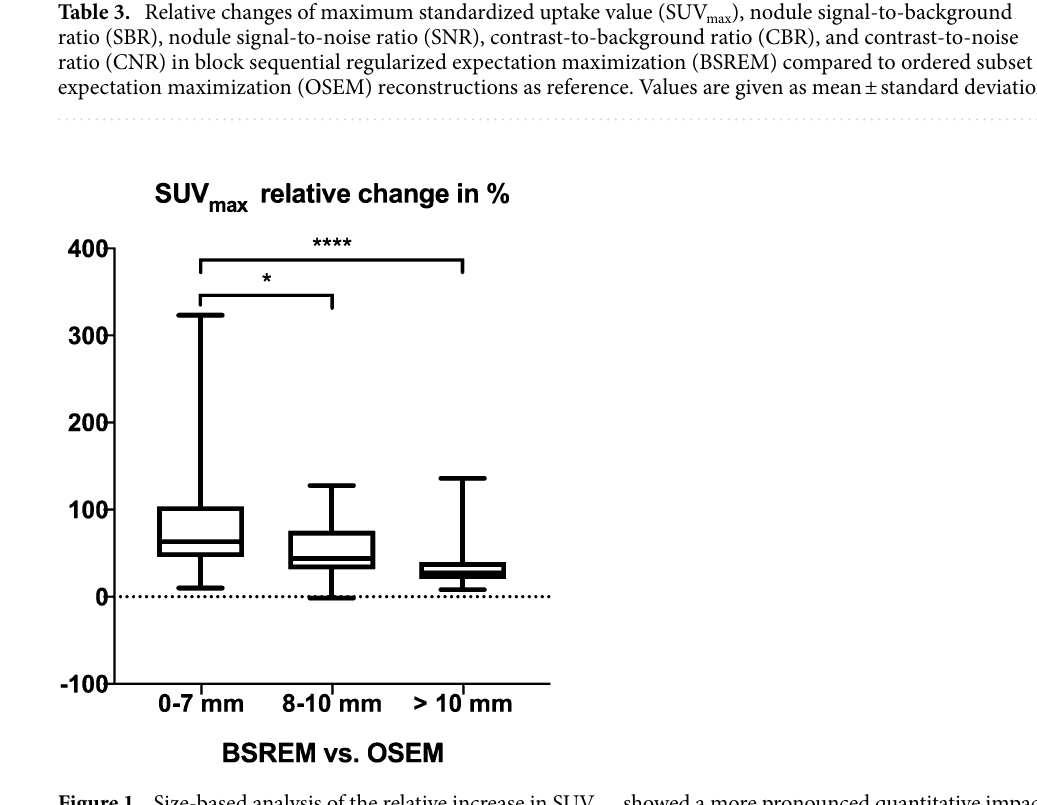
Figure 1. Size-based analysis of the relative increase in SUV max showed a more pronounced quantitative impact in smaller nodules (≤ 7 mm) compared to larger nodules sized 8–10 mm and > 10 mm, (* p value = 0.05, **** p value = 0.0001). The whiskers of the box plot range from minimum to